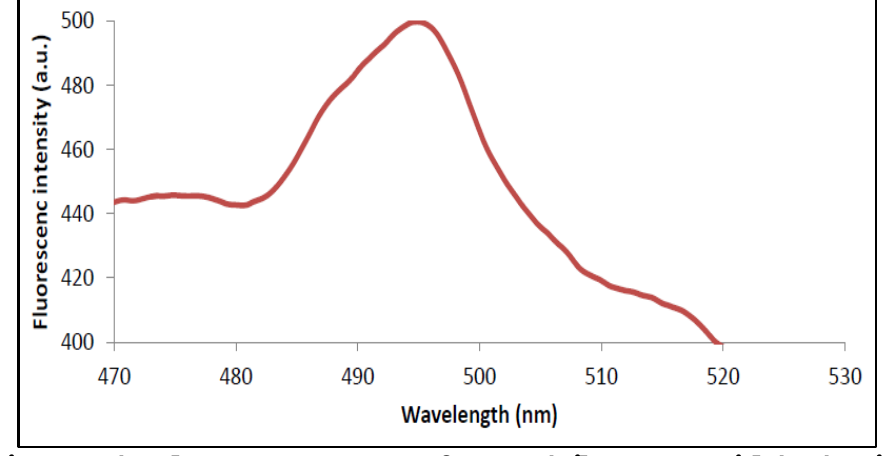
Figure 6: The Fluorescence spectrum of prepared silver nanoparticle by chemical reduction method after 5 minutes from boiling